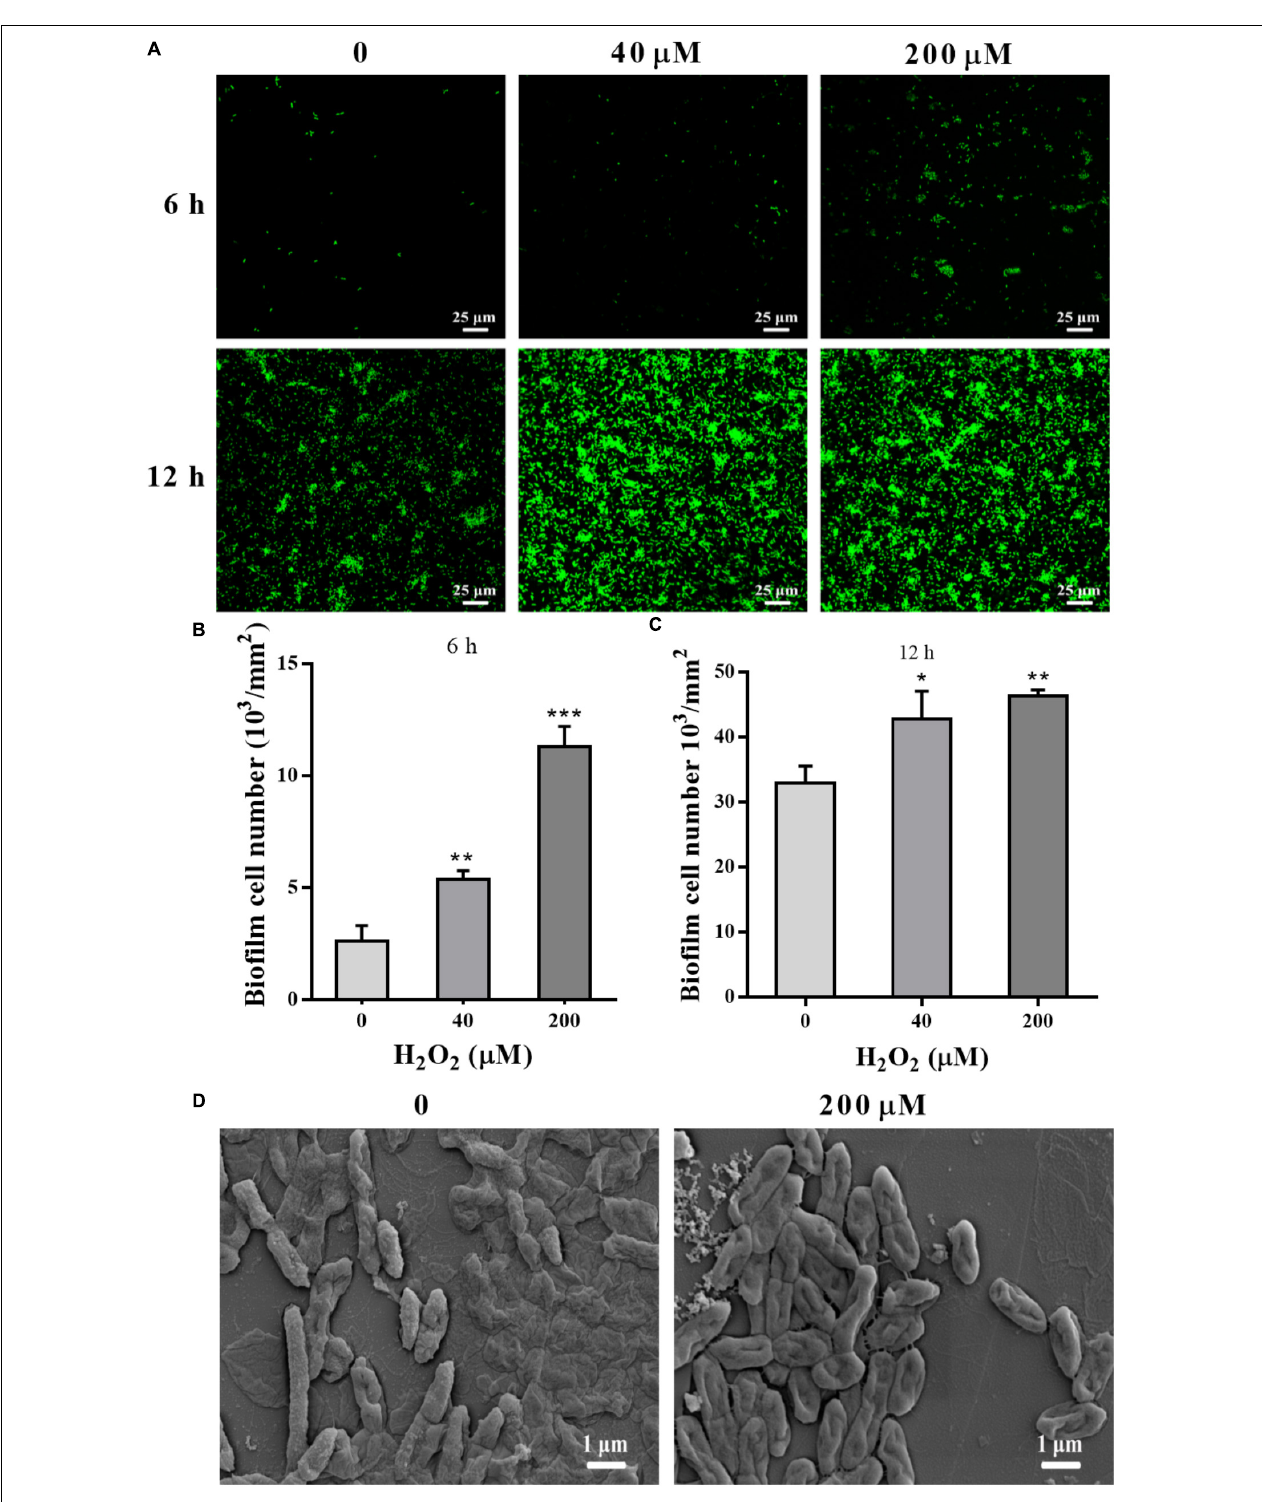
FIGURE 3 | Confocal and FESEM observation of P. putida MnB1 biofilm formation with exogenous H 2 O 2 . After 6 and 12 h cultivation for adhesion, cells were incubated with H 2 O 2 (0, 40, and 200 µ M) for another 2 h, respectively. (A) Confocal observation of biofilm formation onto glass coverslips by STYO 9 staining (scale bar, 25 µ m). Fluorescently labeled biofilm cells on the glass coverslips after incubation for 6 h (B) and 12 h (C) were quantified (field of vision, 276.79 × 276.79 µ m) ( n = 3). (D) FESEM images of P. putida MnB1 adhered to rhodochrosite with and without 200 µ M H 2 O 2 incubation for 12 h (scale bar, 1 µ m). Data were expressed as mean ± SEM. Significance, ∗ P < 0.05, ∗∗ P < 0.01, and ∗∗∗ P < 0.001 vs. control group (0 µ M H 2 O 2 ).